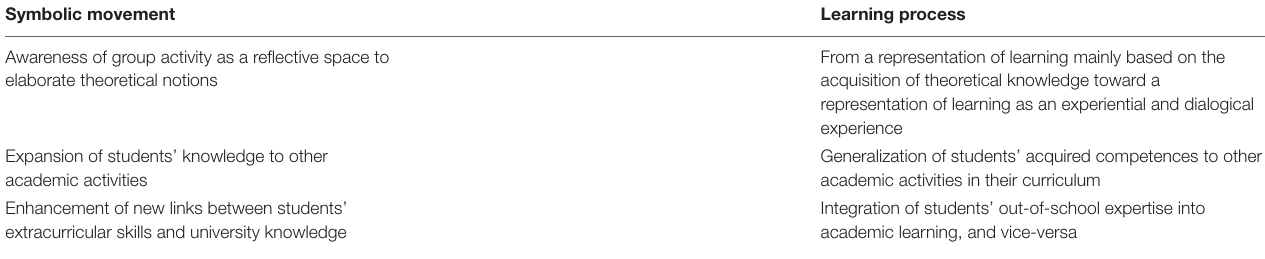
TABLE 2 | Students’ symbolic movements and emerging learning